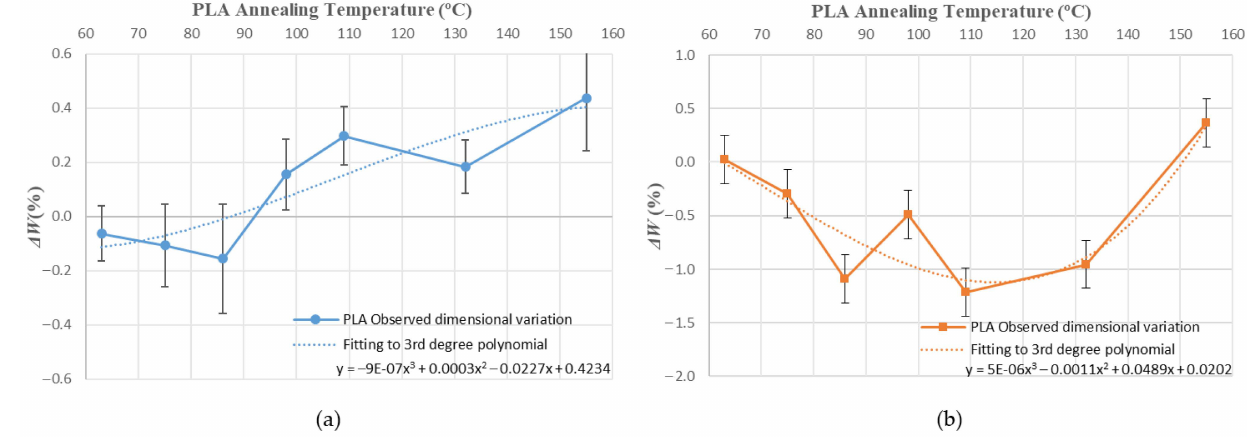
Figure 13. PLA width variation vs. annealing temperature third-degree polynomial approximation: ( a ) without mould; ( b ) with mould.